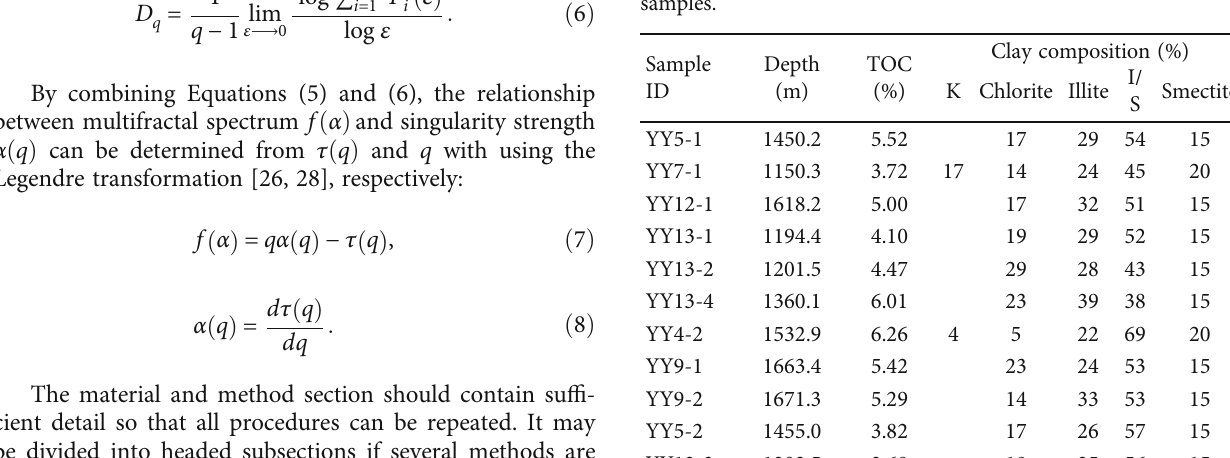
Table 2: Clay mineral composition for Yanchang lacustrine shale